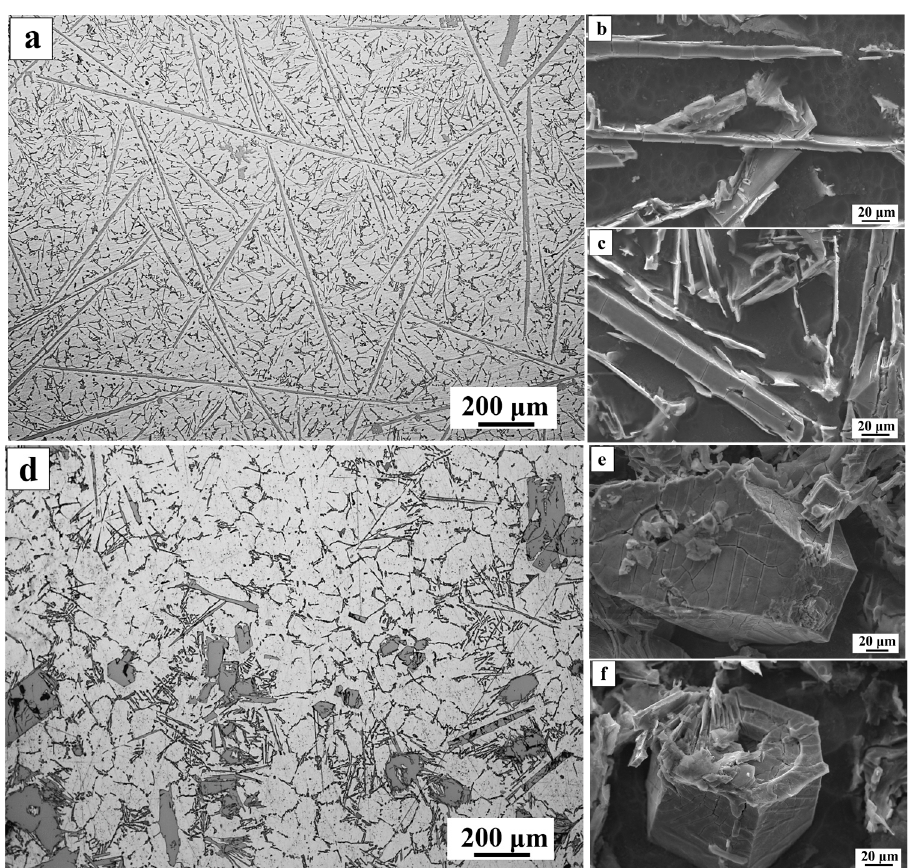
Figure 3. ( a ) OM of as-cast Al-7Si-3Fe alloy; ( b-c ) 3D morphologies of β -Al 5 FeSi phase; ( d ) OM of as-vibration Al-7Si-3Fe alloy; ( e-f ) 3D morphologies of α -Al 8 Fe 2 Si phase.